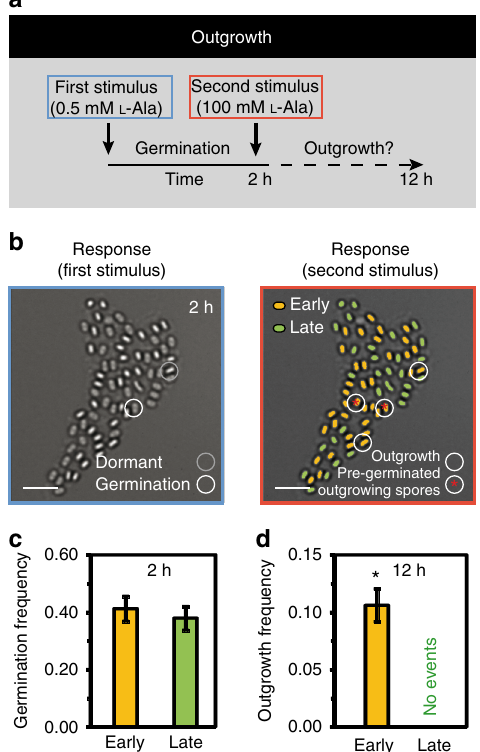
Fig. 4 Early spores are capable of L -alanine-induced outgrowth. a Schematic depiction of the two-step stimulation experiment. Spores stall in the germinated state after the fi rst weak stimulus. In response to the second stronger stimulus, a fraction of germinated spores will grow out. b Image of a representative microcolony that has completed the germination response to the fi rst weak stimulus and a corresponding false-colored image that indicates the outgrowth response of all spores to the second, stronger stimulus. Notably none of the germinated late spores grew out. Scale bar: 5 µ m. c Germination frequencies in response to the fi rst stimulus. d Outgrowth frequencies in response to the second stimulus. Strain: